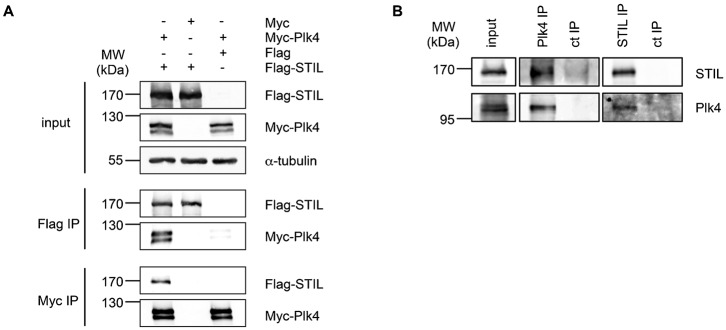
STIL interacts with Plk4 in vivo.(A) Coimmunoprecipitation of Flag-STIL and Myc-Plk4. Lysates from HEK293T cells transfected with the indicated plasmids were subjected to immunoprecipitations using anti-Flag or anti-Myc antibodies. Input and IP samples were analyzed by western blotting with antibodies against Flag-tag or Plk4 and α-tubulin as loading control. (B) Coimmunoprecipitation of endogenous STIL and Plk4. Endogenous Plk4 and STIL were immunoprecipitated from HeLa lysates by anti-Plk4 and anti-STIL antibodies. IP with non-specific IgGs served as a control. Coimmunoprecipitated proteins were detected by western blotting using anti-Plk4 and anti-STIL antibodies.